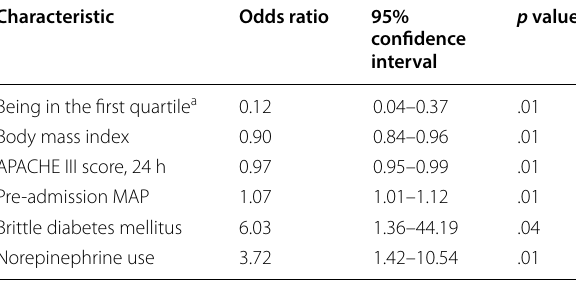
APACHE acute physiology, age, chronic health evaluation, MAP mean arterial pressure a Patients had ΔMAP values in the lowest quartile